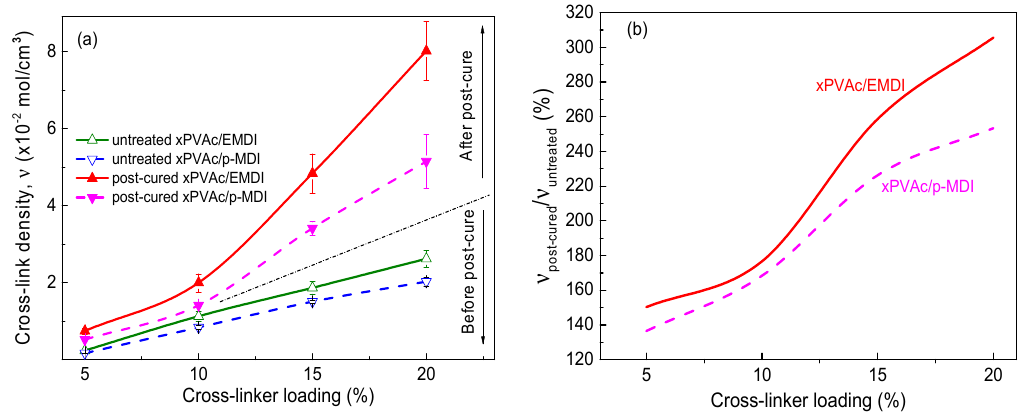
Figure 8. Effect on the ( a ) cross-link density and ( b ) ratio cross-link density of EPI film before and after post-curing at 80% RH.